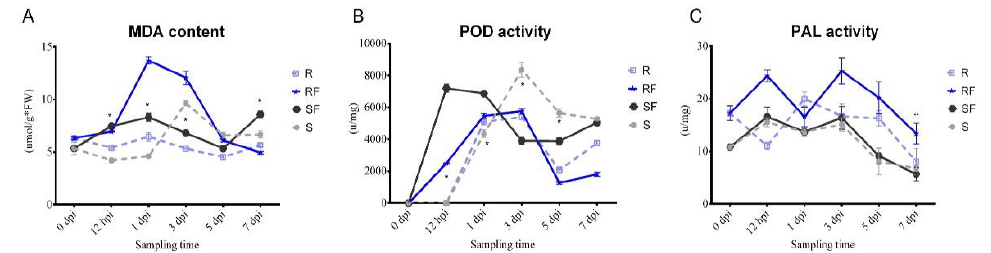
Figure 3. Comparison analysis of physiological indexes changes: ( A ) Dynamic changes in MDA content at different sampling time in different samples; ( B ) Dynamic changes in POD enzyme activ- ities at different sampling time in different samples; ( C ) Dynamic changes in PAL enzyme activities at different sampling time in different samples. S, Susceptible cultivar + mock-inoculation control (H 2 O 2 ); R, Resistant cultivar + mock-inoculation control (H 2 O 2 ); SF, Susceptible cultivar + FON; RF, Resistant cultivar + FON. Moreover, 0 dpi (before treatment); 12 hpi (12 h post inoculation); 1 dpi (1 day post inoculation); 3 dpi (3 days post inoculation); 5 dpi (5 days post inoculation); 7 dpi (7 days post inoculation). Data were expressed as mean ± SE ( n = 3). Multiple t tests of Two-way ANOVA (*, p ≤ 0.001; **, p ≤ 0.0001).